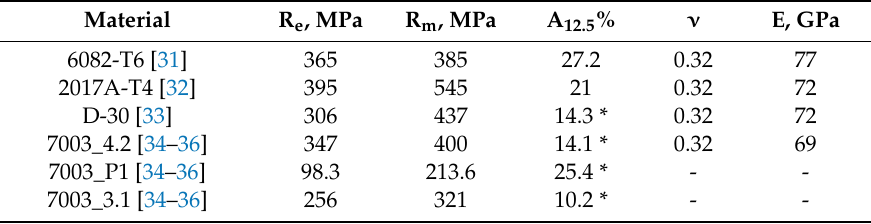
Table 2. Basic mechanical parameters of the analyzed